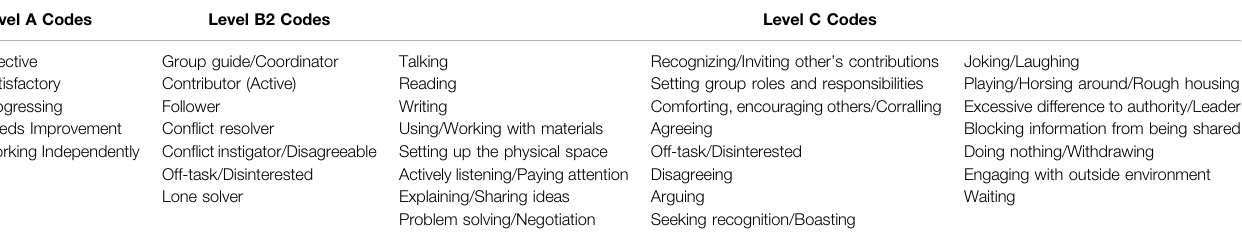
TABLE 1 | Coding rubric for levels A, B2 and C. The coding rubric for levels B2 and C was fi rst discussed in (Som et al., 2020). Level A Codes